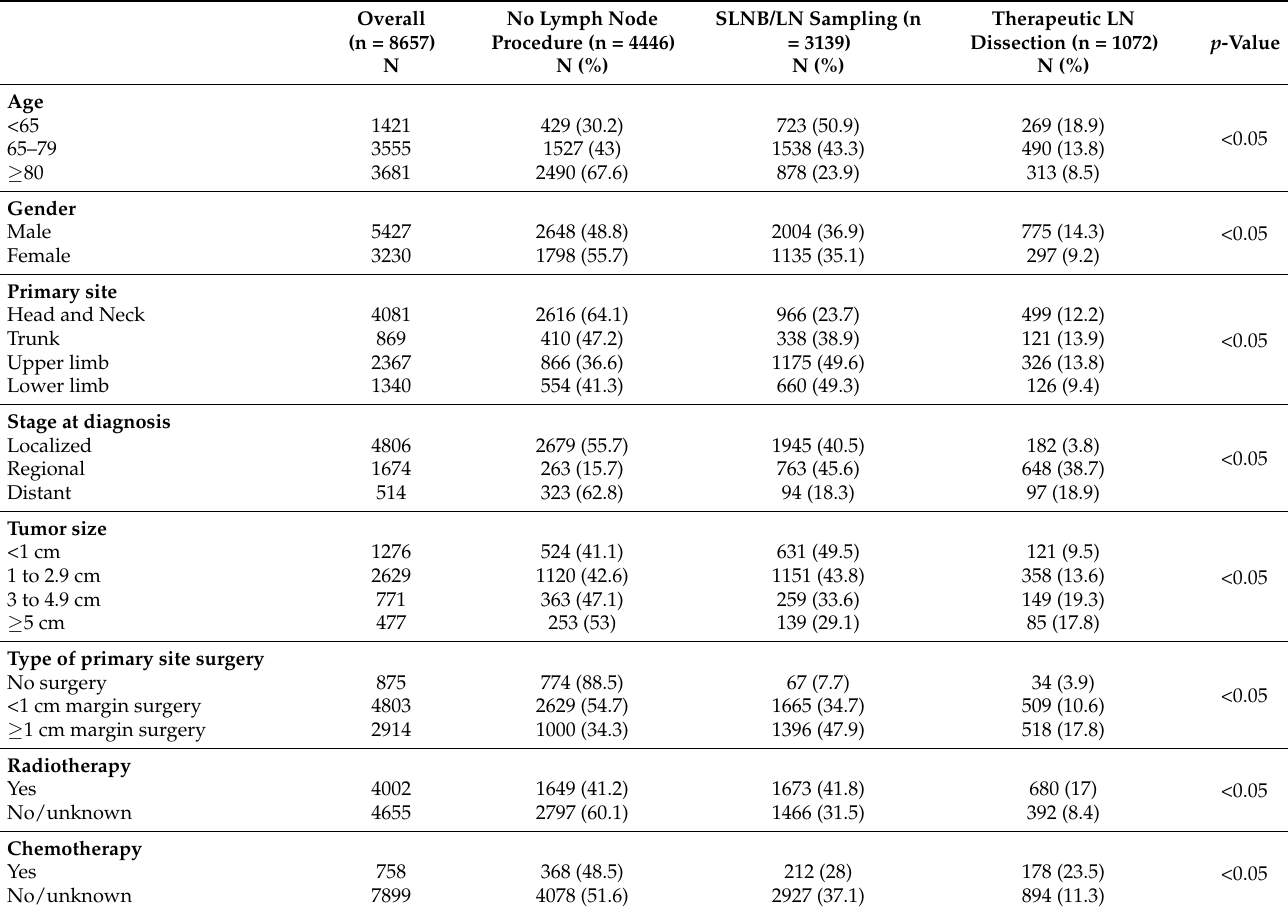
Table 1. Lymph node procedure distribution according to demographic, tumor and treatment